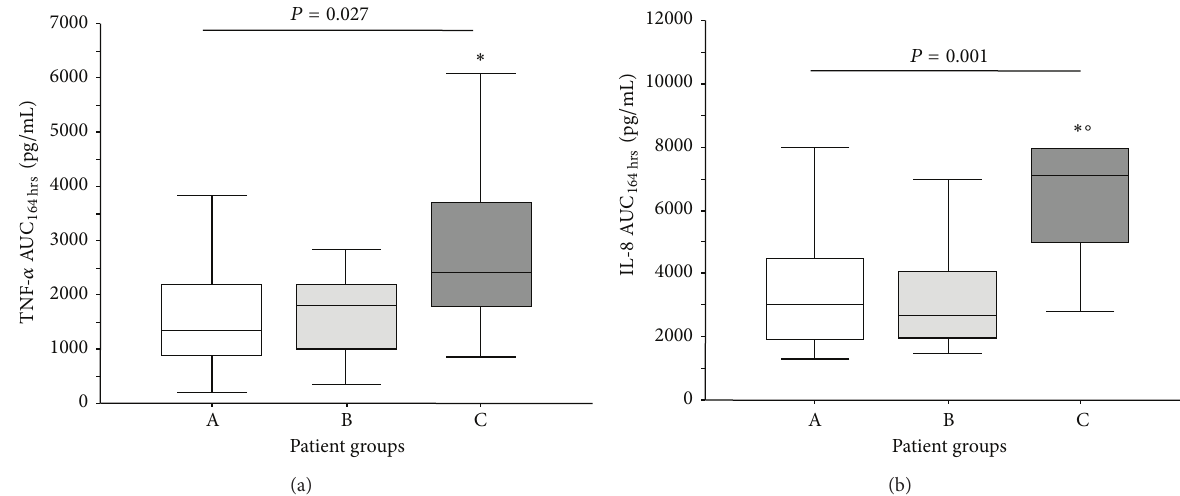
) in patients that hrs